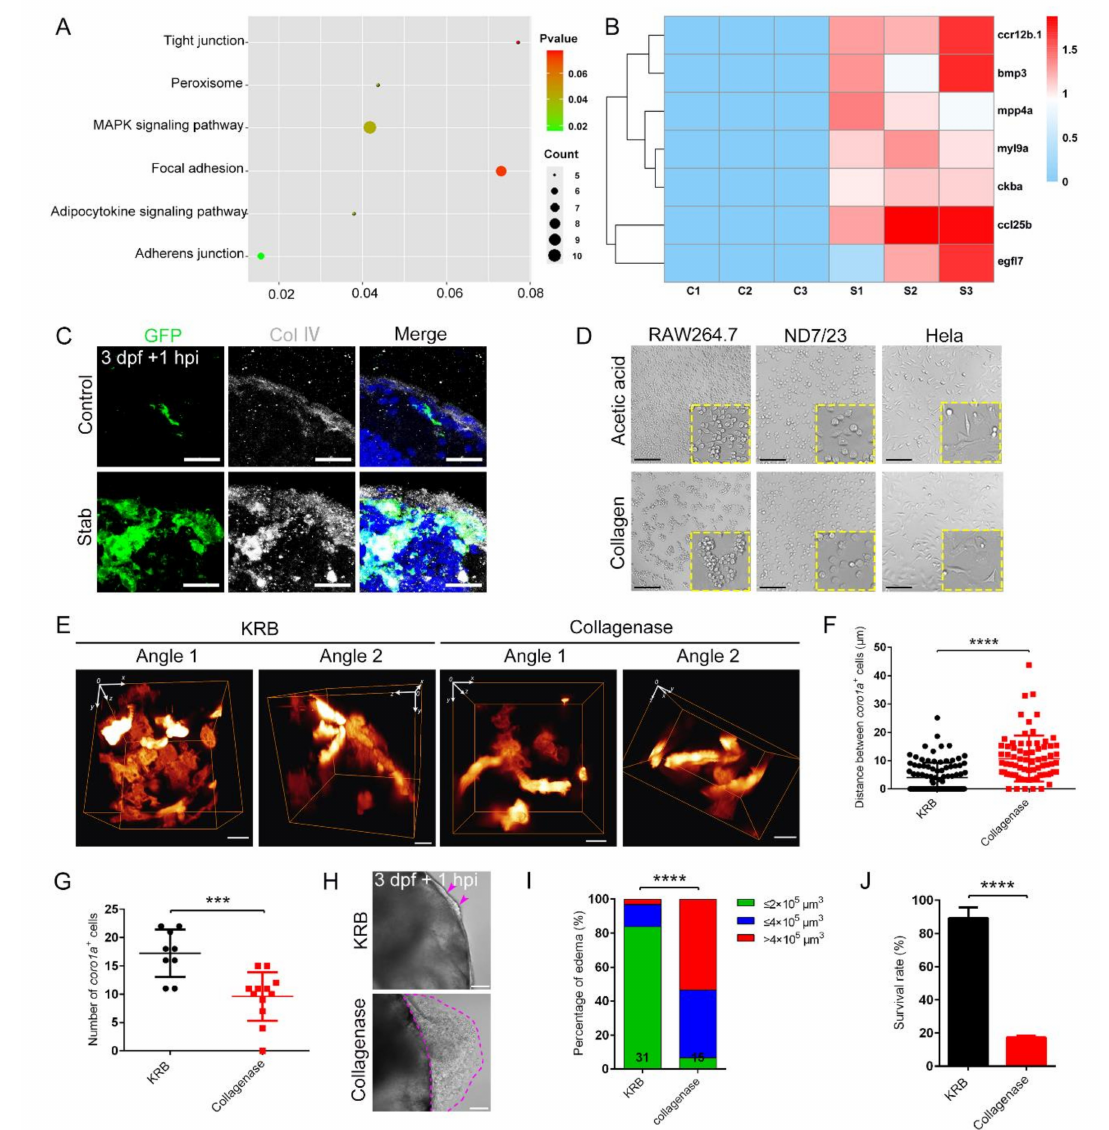
Figure 7. Collagenase disrupted macrophage aggregation and caused severe edematous symptoms. ( A ) Analysis of the altered signaling pathways in labeled red coro1a -Kaede + cells before and after injury. ( B ) Heat map of changed representative genes. ( C ) Immunofluorescence imaging of GFP and type IV collagen (Col IV) on frozen sections of stabbed Tg(coro1a:eGFP) brain. Scale bar, 20 µ m. ( D ) Observation of cell aggregation in the RAW264.7 cell lines, HeLa cell lines and ND7/23 cell lines with collagen/acetic acid added. Scale bar, 100 µ m. ( E ) The distribution of macrophages after collagenase treatment in Tg(coro1a:DsRed) embryos at 1 hpi. KRB, Krebs–Ringer bicarbonate buffer, collagenase solvent. Scale bar, 10 µ m. ( F ) Statistical analysis of distances between the macrophages in ( E ). KRB, 4.01 ± 0.53 µ m n = 96; Collagenase, 10.67 ± 0.94 µ m n = 75. ( G ) Statistical analysis of aggregated coro1a + cells number in ( E ). KRB, 17.22 ± 1.40 n = 9; Collagenase, 9.58 ± 1.23 n = 12. ( H ) Observation of edematous symptoms (purple dished lines) after collagenase/KRB injection. Purple arrowheads indicate a mild edematous phenotype. Scale bar, 50 µ m. ( I ) Statistics of edematous symptoms of the injured larvae after collagenase/KRB injection. ( J ) Survival rate of the stabbed larvae after collagenase/KRB injection. (Data are shown as mean ± SEM. ***, p < 0.001; ****, p <